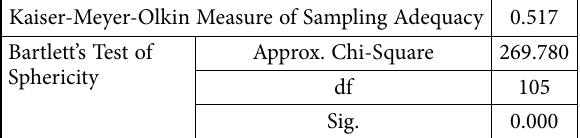
Table 3. KMO and Bartlett’s Sphericity Test